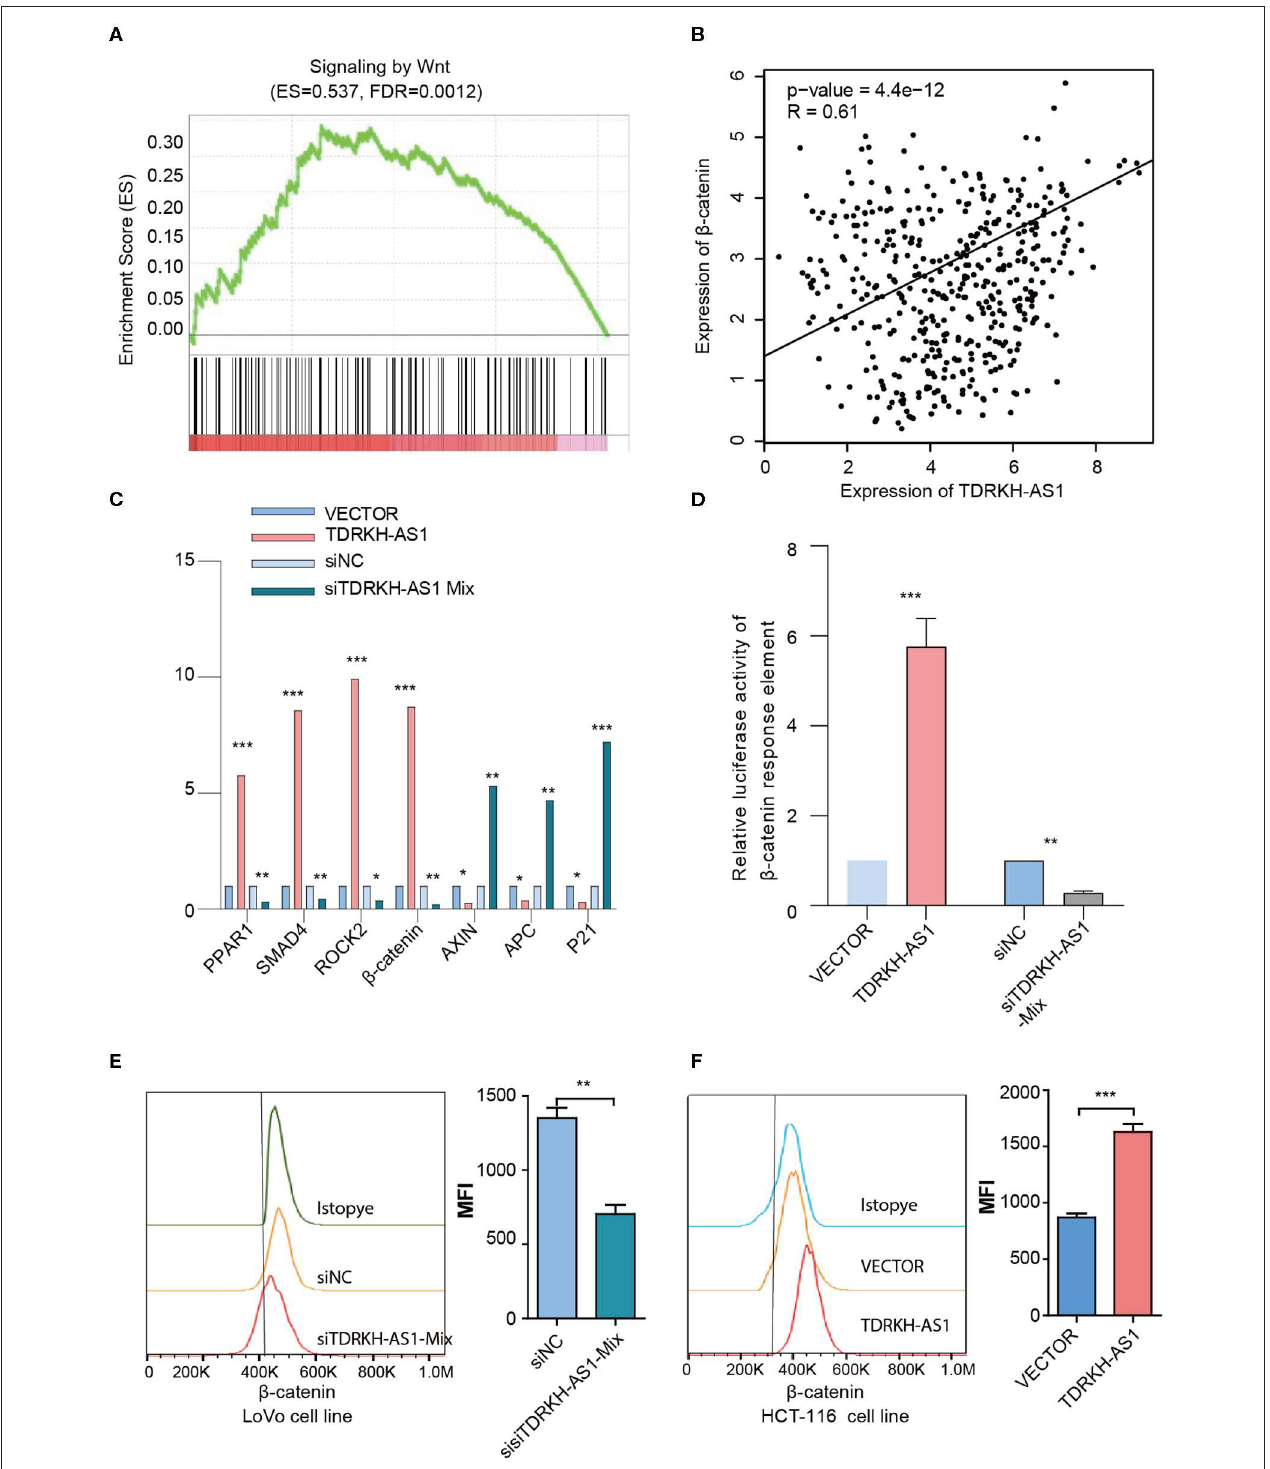
FIGURE 4 | TDRKH-AS1 performs its biological functions through the Wnt signaling pathway. (A) The gene set enrichment analysis of the Wnt signaling pathway. (B) The expression of TDRKH-AS1 was significantly positively correlated with the expression of β -catenin. (C) The quantitative real-time PCR results show that overexpression or knockdown of the TDRKH-AS1 significantly affected the expression of driver genes in the Wnt signal pathway. (D) The luciferase activity shows that overexpression or knockdown of TDRKH-AS1 will significantly affect the expression of β -catenin. (E,F) The flow cytometry assay shows that overexpression or knockdown of the expression of TDRKH-AS1 can affect the expression of the β -catenin protein. Statistics were considered to be at a significant level when p < 0.05, where * p < 0.05, ** p < 0.01, and *** p < 0.001.